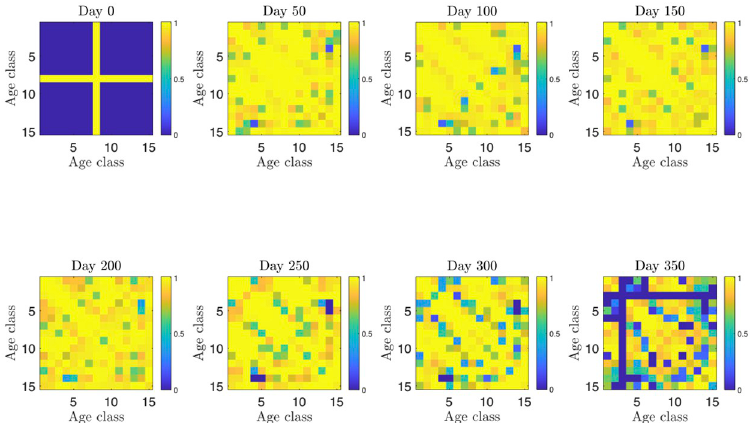
Fig 8. Intensity of lockdown within the found solution for the different age classes and for selected days over the considered time horizon. The intensity is shown with a blue to yellow scale, where blue represents no social distancing and yellow a complete lockdown.